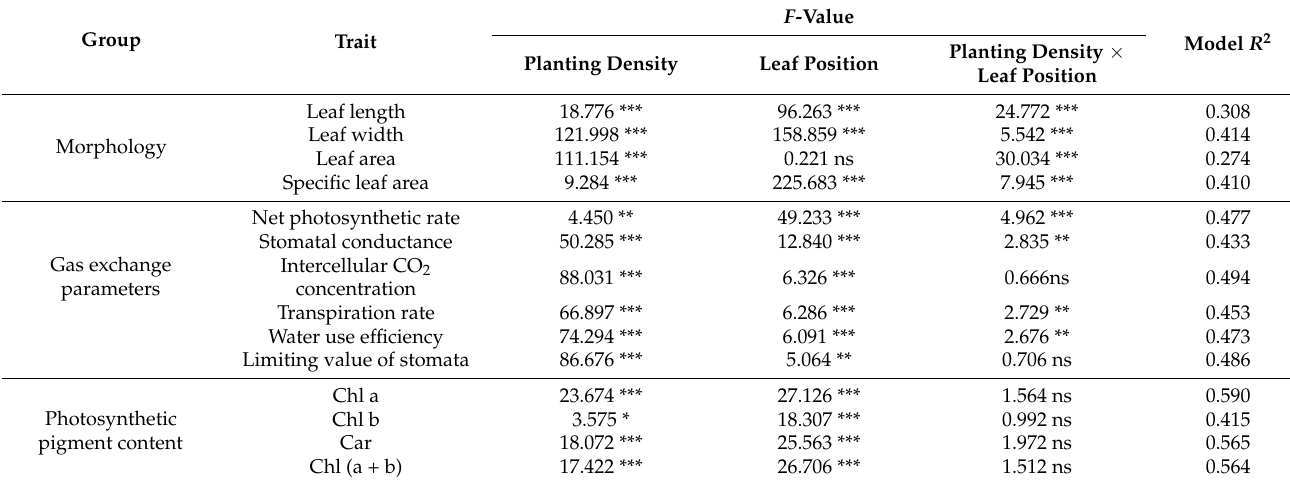
Table 1. Summary of ANOVA for main effects of density (df = 2), position (df = 3), and interactions (df = 6) with leaf morphology and photosynthetic characteristics of C. lanceolata saplings ( n = 9).